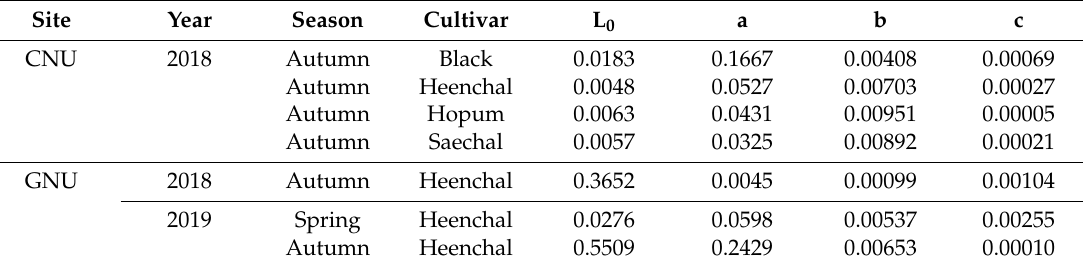
Table A1. Converged parameters of initial leaf area index (L 0 ) and leaf partitioning and senescence (a, b, and c) after the within-season calibration of the remote sensing-integrated barley model for cultivars seeded in autumn 2018 at Chonnam National University (CNU), Gwangju and for Heenchal seeded